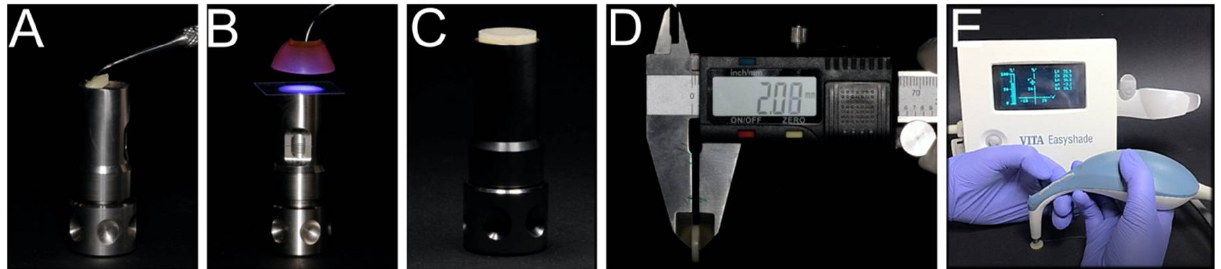
Figure 1. Preparation of the specimens: ( A ) Resin-matrix composite was placed in a stainless-steel mold for ( B ) light-curing using an LED unit. The specimens were ( C ) polished and ( D ) inspected with a digital caliper. ( E ) Color measurements were performed on each specimen using a spectrophotometer.